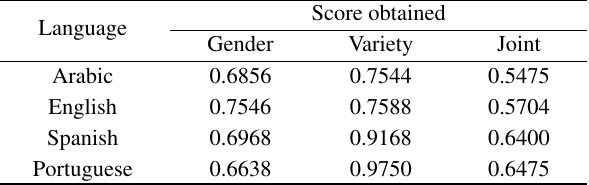
Table 12 Results obtained from Kheng et al.